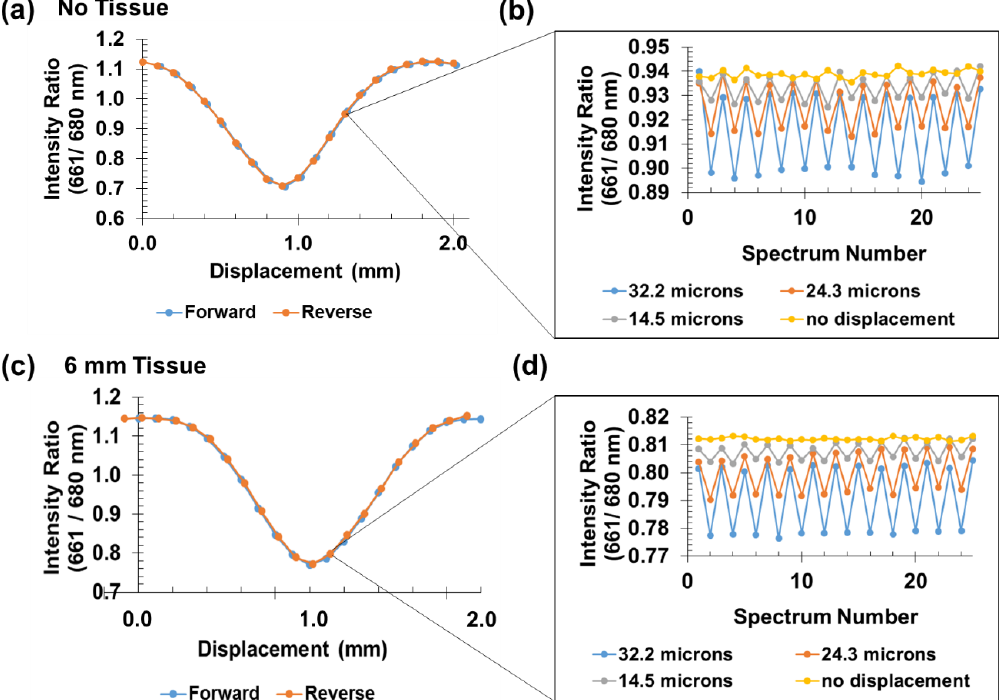
Figure 6. Sensor response over 2 mm displacement and small cyclic displacements measured with and without tissue. ( a , c ) show spectral ratio (I 661 /I 680 ) vs. sensor displacement for a travel distance of 2.0 mm. Each point represents a 100 µm displacement. ( b , d ) show reproducible spectral ratios for a single position (single forward displacement followed by a return to the initial position). All displacement measurements in ( a , c ) were corrected for backlash of the motorized stage. Measurements were acquired with a 1.0 s exposure.